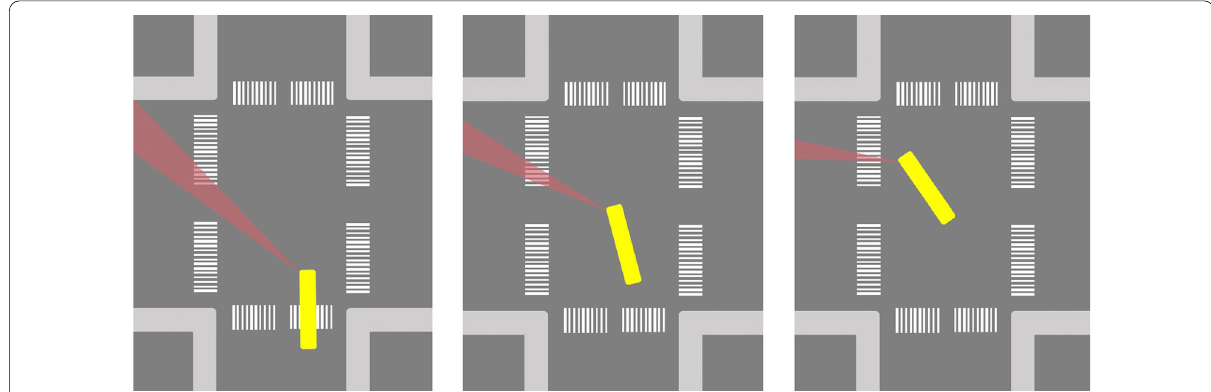
Fig. 8 Schematic illustration of how the A-pillar blind zone (red area) of a left-turning bus (yellow) may sweep across a crosswalk and potentially obscure a crossing pedestrian until right before